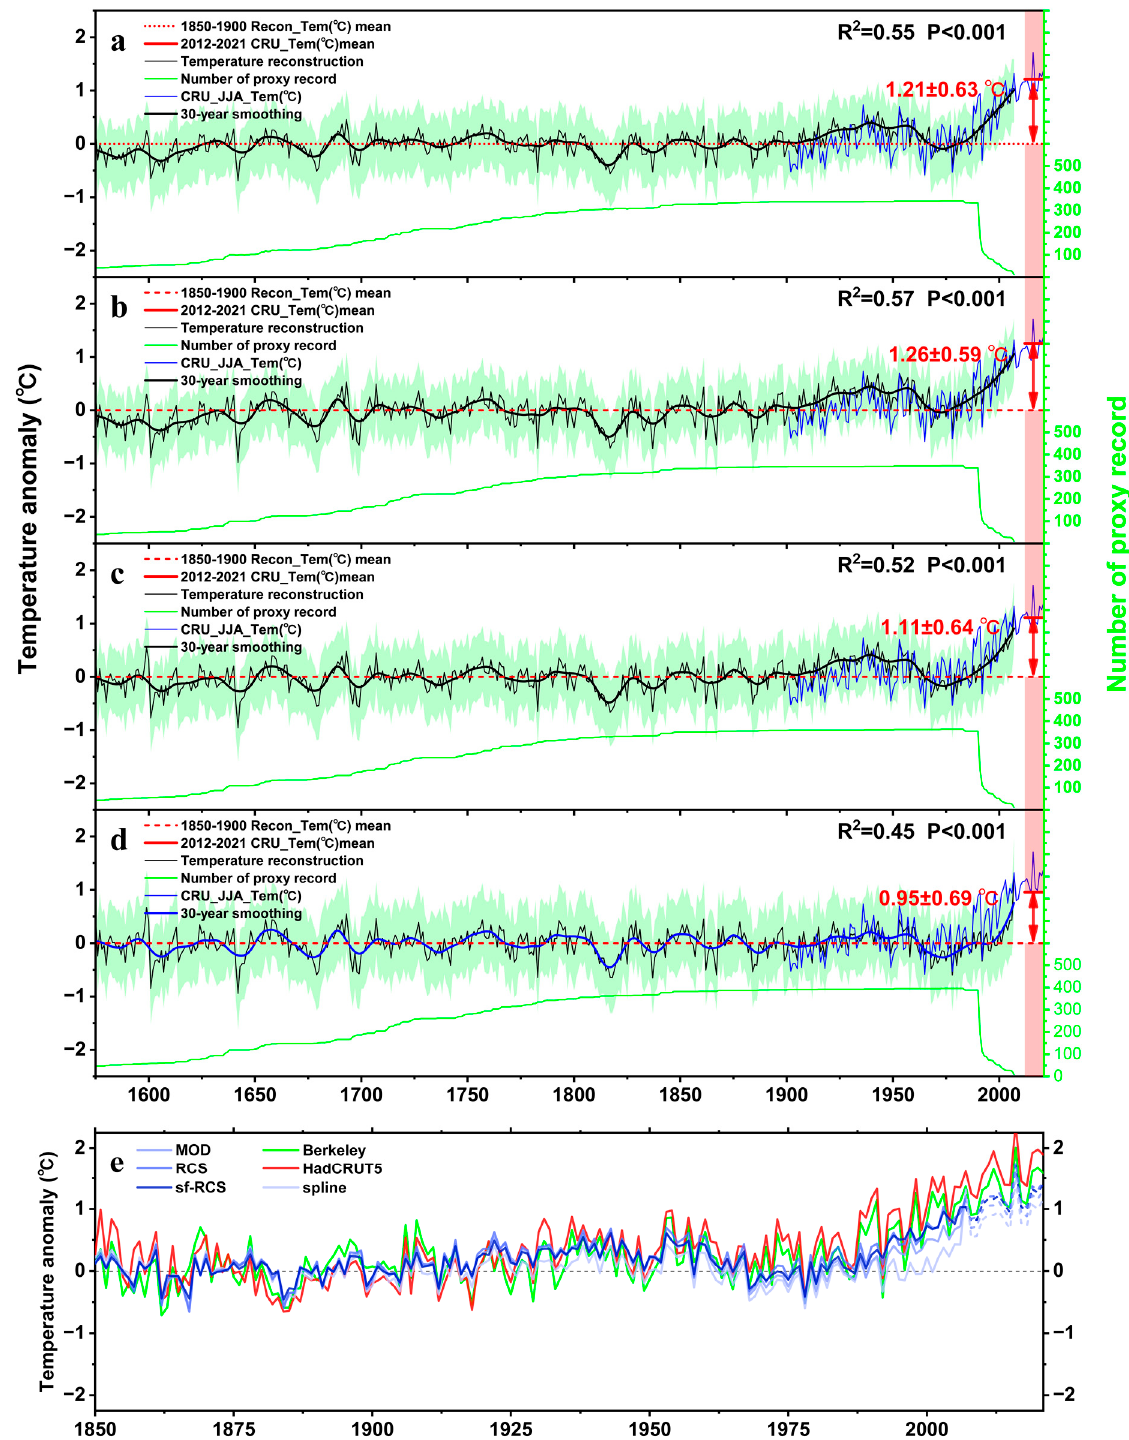
Figure 2. ( a ) Instrumental (CRU TS 4.06, blue line) and reconstructed (thin black line) Arctic summer Temp using sf-RCS detrending. Green shading is the 95% confidence interval. The green line is the number of tree-ring records combined for reconstruction, and the thick black line is the 30-year LOESS smoothing. The red dotted and thick red horizontal lines represent the mean values of the 1850–1900 reconstruction and 2012–2021 CRU summer Temp; the difference between the two values, represented by the summer Arctic warming amplitude, is denoted with transparent red bars and arrows. ( b – d ) The same as a but for reconstructions using RCS, MOD, and spline detrending. ( e ) Summer Temp anomalies relative to 1850–1900 for our reconstruction and instrumental Temp datasets.